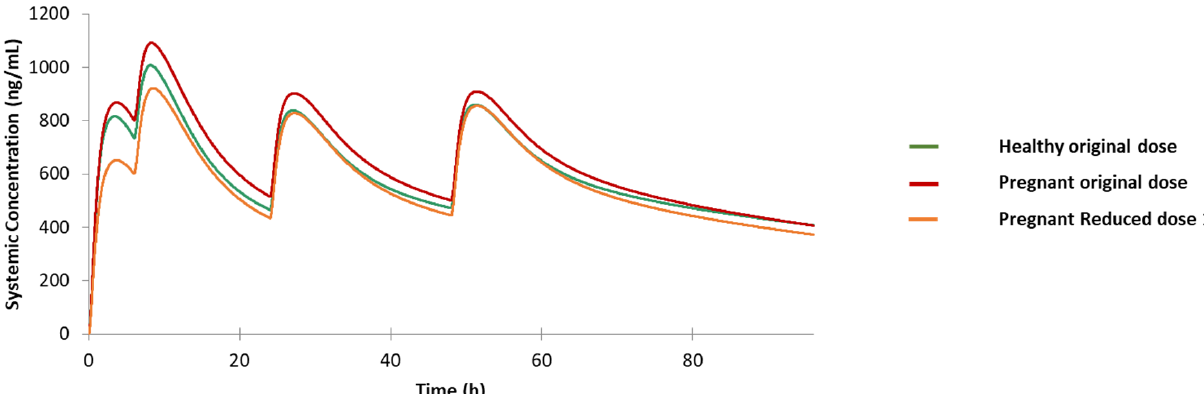
Figure 5. Predicted drug concentration for the healthy population under original dose, pregnancy population under original dose, and pregnancy population under Reduced dose 1.